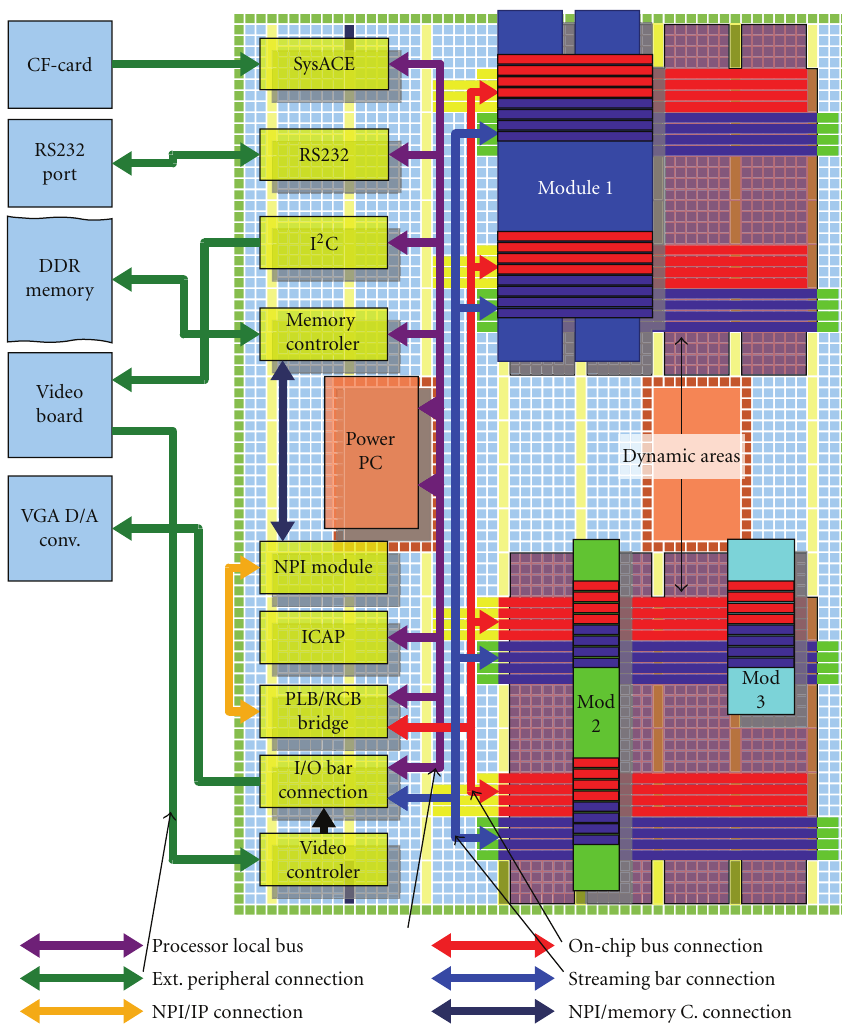
Figure 6: System overview of one possible partitioning of a heterogeneous FPGA-based SoC platform consisting of CPU subsystem and reconfigurable area from [15]. Reconfigurable modules can vary in size and be freely placed, allowing a very good exploitation of the FPGA space. The on-chip ReCoBus (red) and the streaming bar (blue) are routed through the dynamic part, allowing a systemwide communication between hardware and software